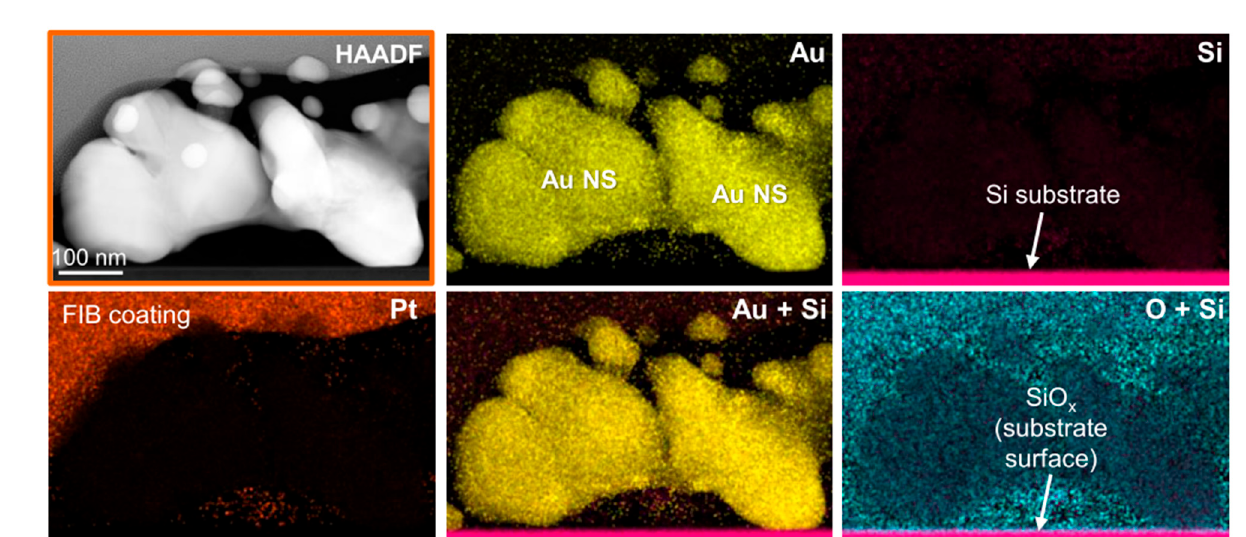
Figure 8. ( a – c ) HAADF and ( d , e ) HRTEM images of the cross-section of different AuNSs made with an LP = 100 mW and ET = 150 ms after TPA–DLW. These images illustrate the autocatalytic growth of the AuNSs after TPA–DLW, before the HAuCl 4 bath (see Figure 1d or Figure 5a). The duration of this growth is estimated as the lag between the TPA–DLW process and the washing step with deionized water (~10 s); AuNPs appear brighter than the background in the HAADF images ( a – c ) since the regions with heavier elements provide a more intense signal in this mode; ( b , d ) show that the AuNSs are physically deposited onto the Si substrate. Arrows in ( d ) indicate merging regions since TPA–DLW is able to create larger structures by the coalescence of smaller individual AuNPs. Different shapes of the individual AuNPs (decahedral, pentagonal bipyramid) are shown in ( c , e ).